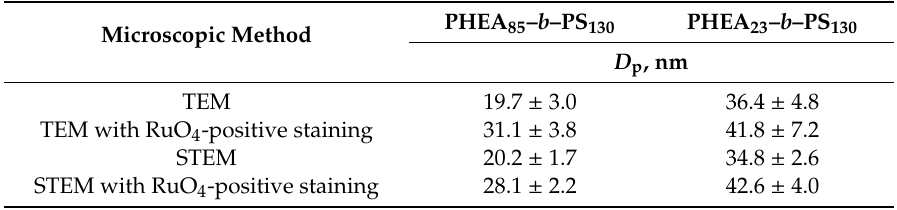
Table 1. Comparison between particle size data determined by TEM and SEM.